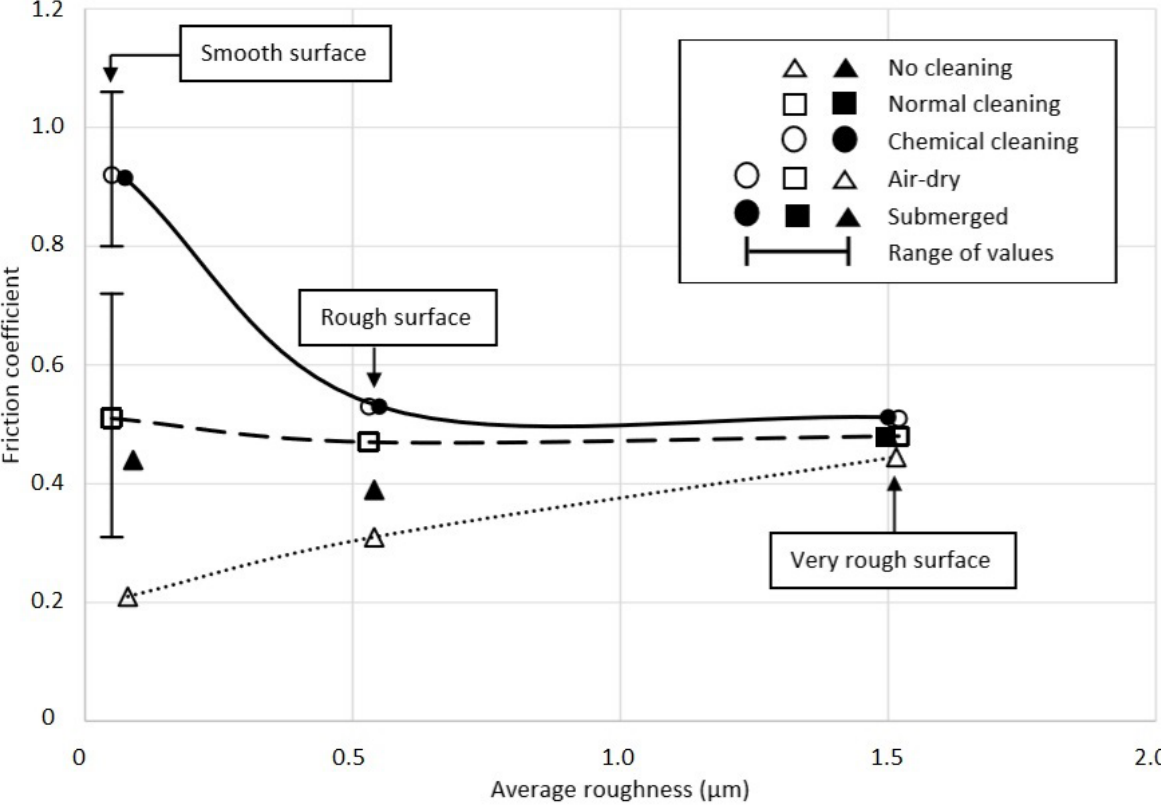
Figure 4 : Friction coefficient of quartz (after Lambe and Whitman 1969, data from Bromwell 1966 and Dickey 1966; replotted).